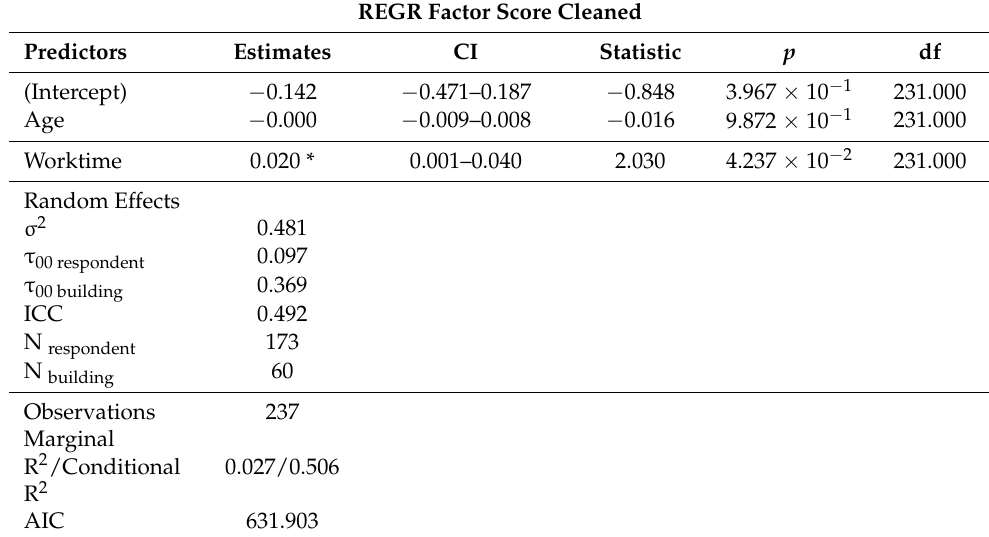
Table 17. Regression model for